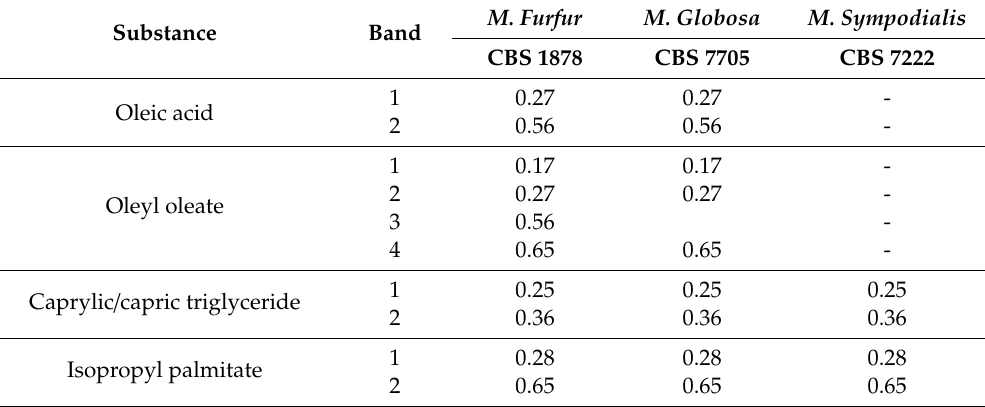
Table 5. Band patterns observed in High Performance Thin Layer Chromatography (HPTLC) M. sympodialis